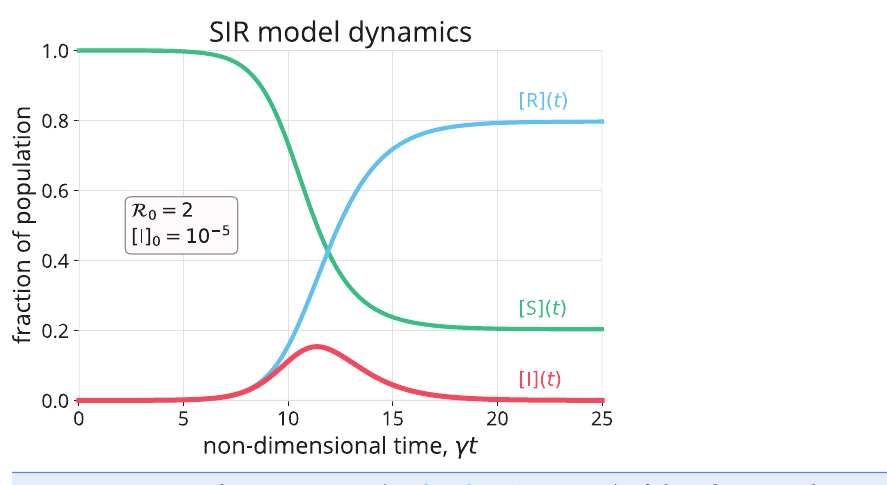
Figure 2 Numerical approximation ( Rackauckas & Nie, 2017 ) of the solution to the SIR model in Eqs. (1) – (3) with initial conditions in Eqs. (6) –